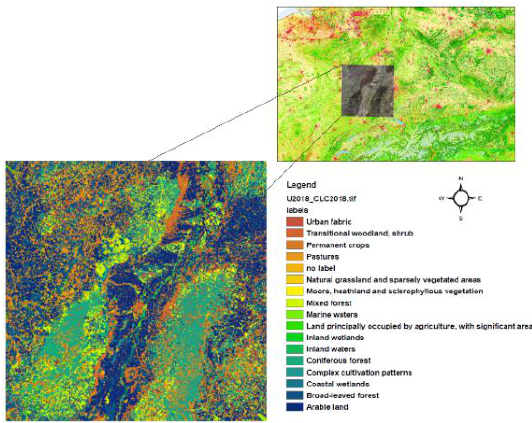
Figure 5 . Ground truth for second data